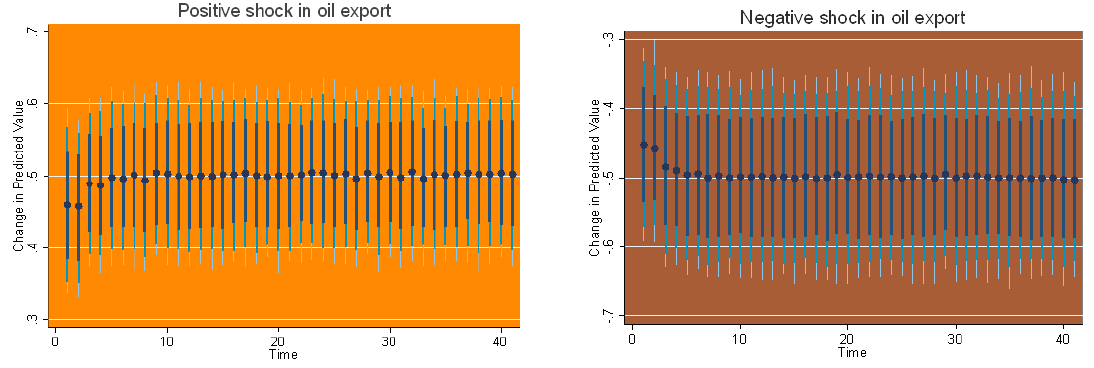
Figure 1. ± 10% shocks in oil export